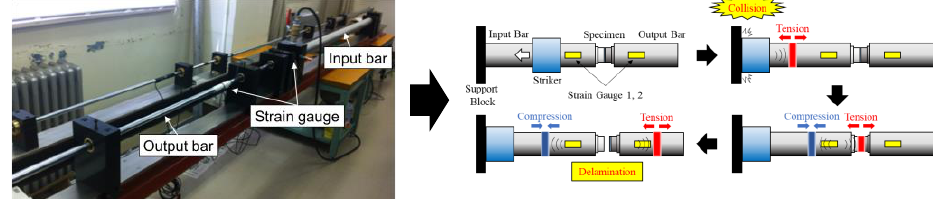
Fig. 1 Experimental setup and overview of SHB